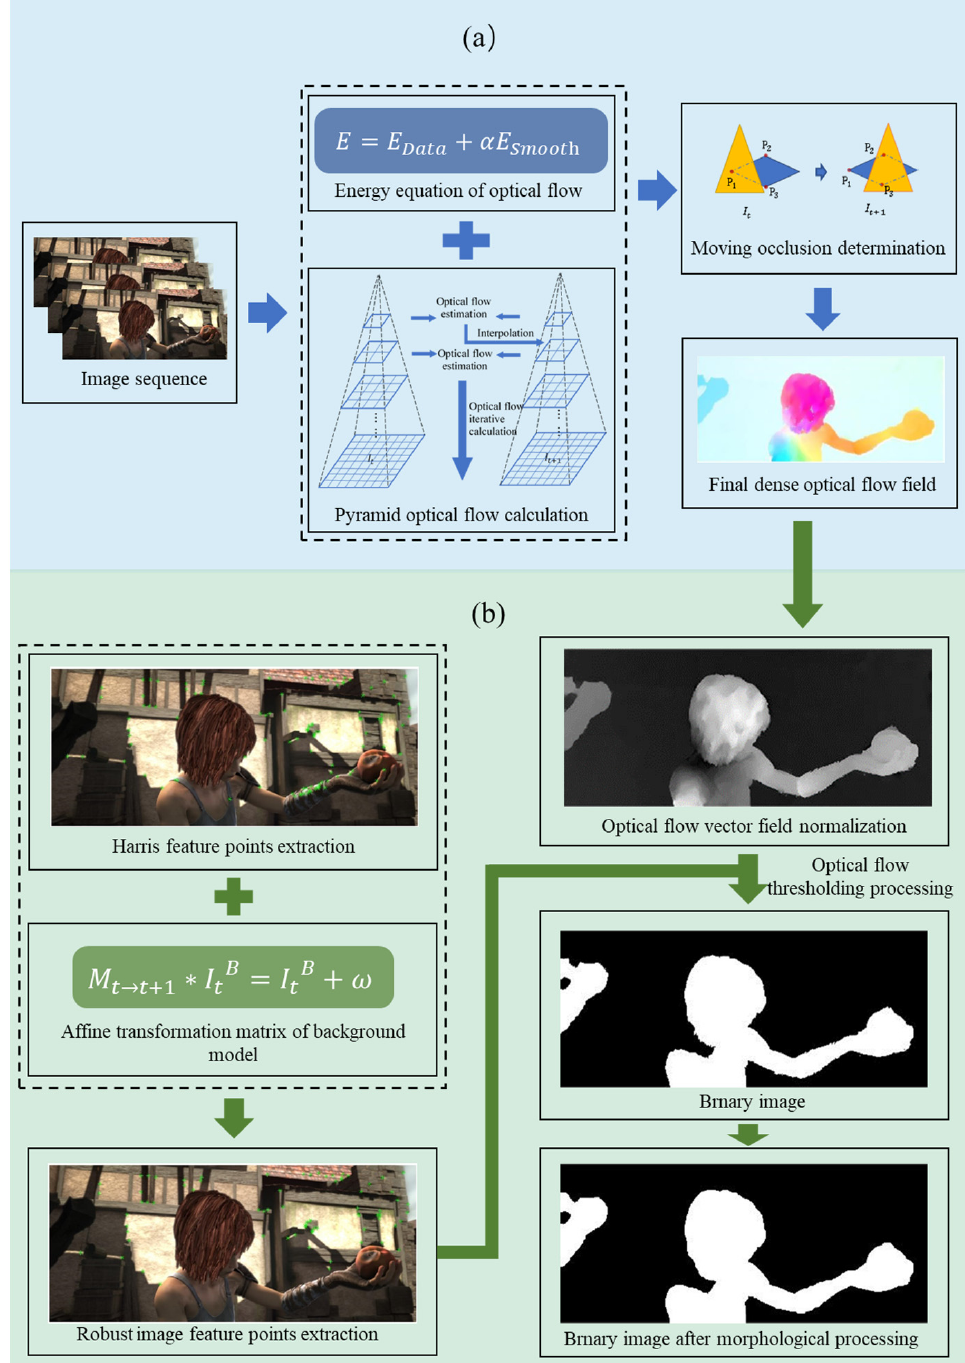
Figure 1. The framework of the algorithm for detecting moving objects with advanced estimated optical flow robust feature threshold segmentation. ( a ) is the optical flow estimation patch, ( b ) is the moving object detection patch